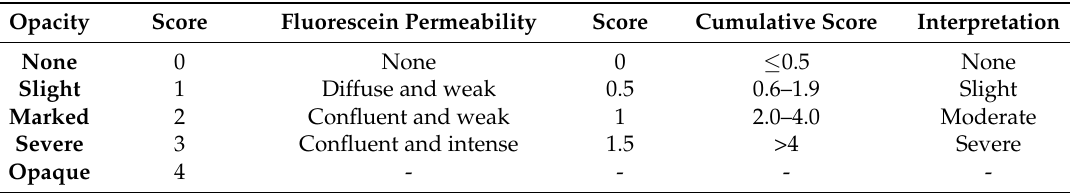
Table 3. Bovine eye scoring